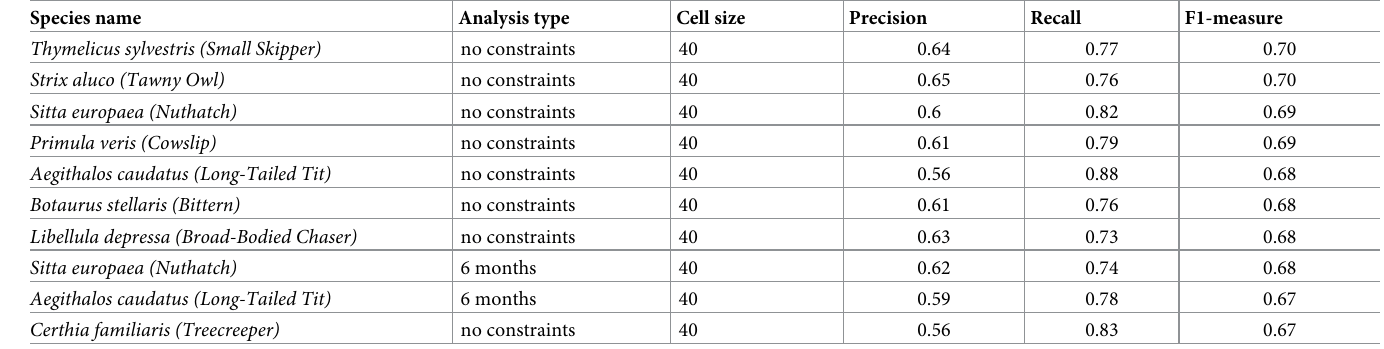
Table 6. The top ten results with the highest f1-measure across all species.